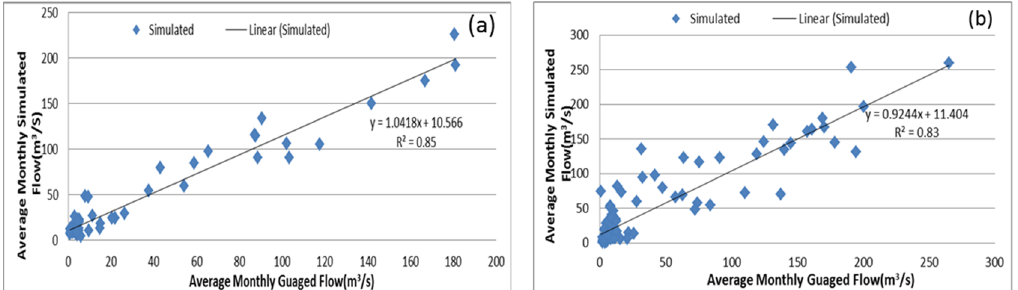
Figure 10. Scatter plot of monthly simulated and gauged flow for ( a ) calibration and ( b ) validation periods at Hombole station. Table 3. Model statistical and performance indicators for streamflow simulations in the calibration and validation periods.